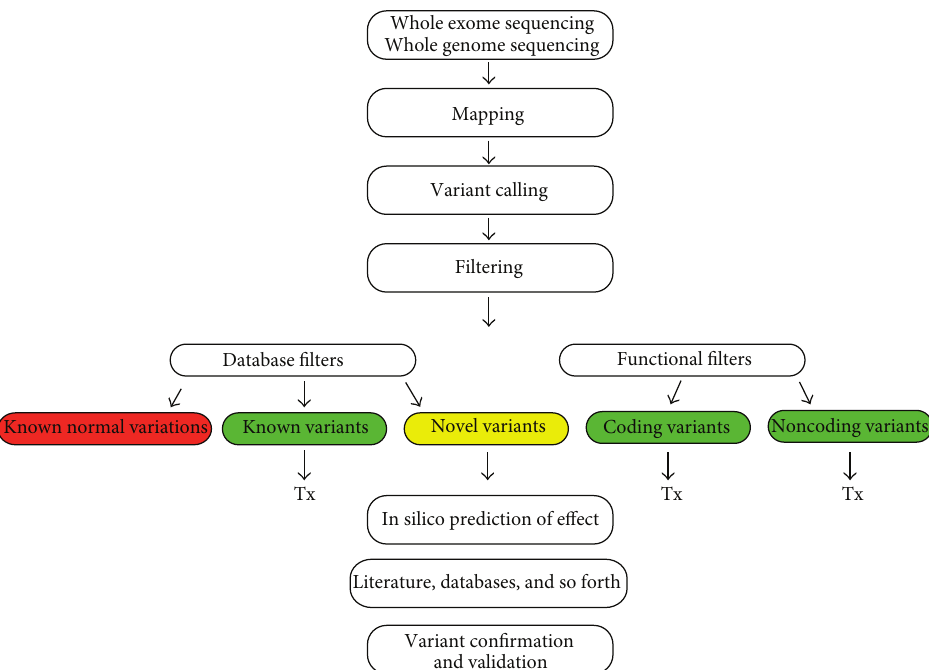
validationLiterature, databases, and so